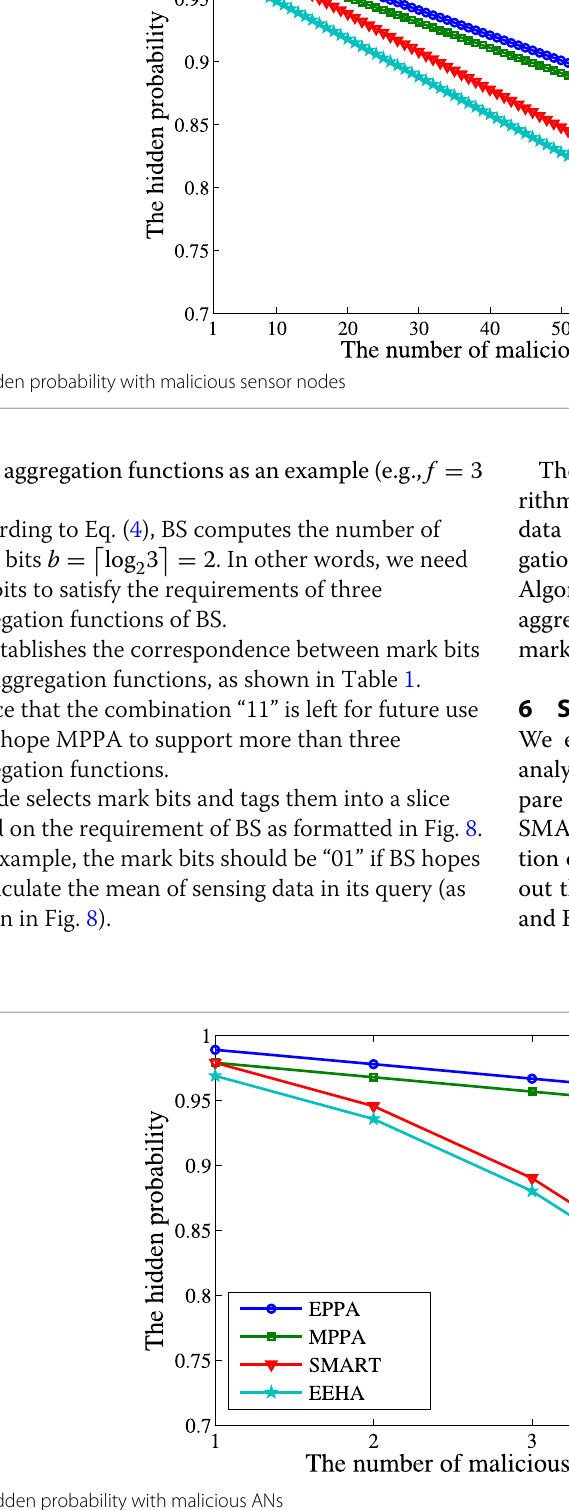
Fig. 10 Hidden probability with malicious